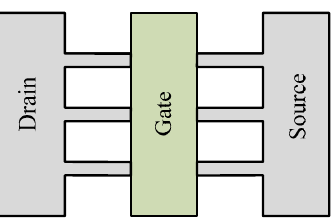
Figure 12. Graphene nano-ribbon structure of FinFET [50].